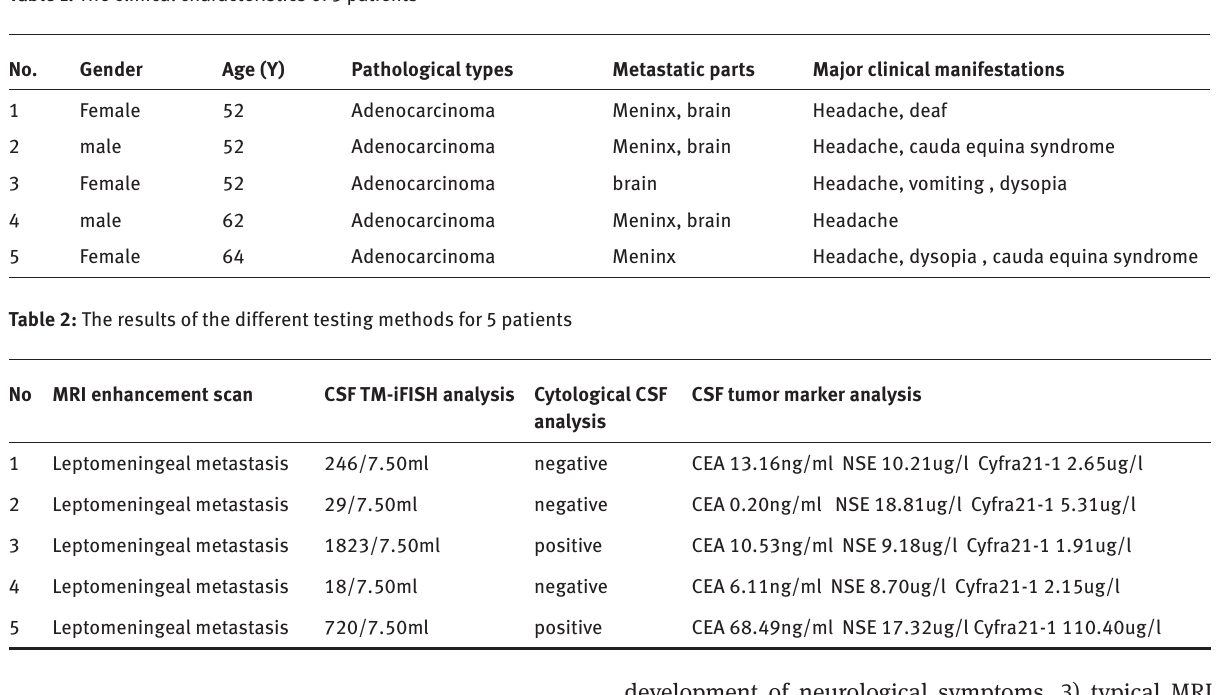
Table 1: The clinical characteristics of 5 patients